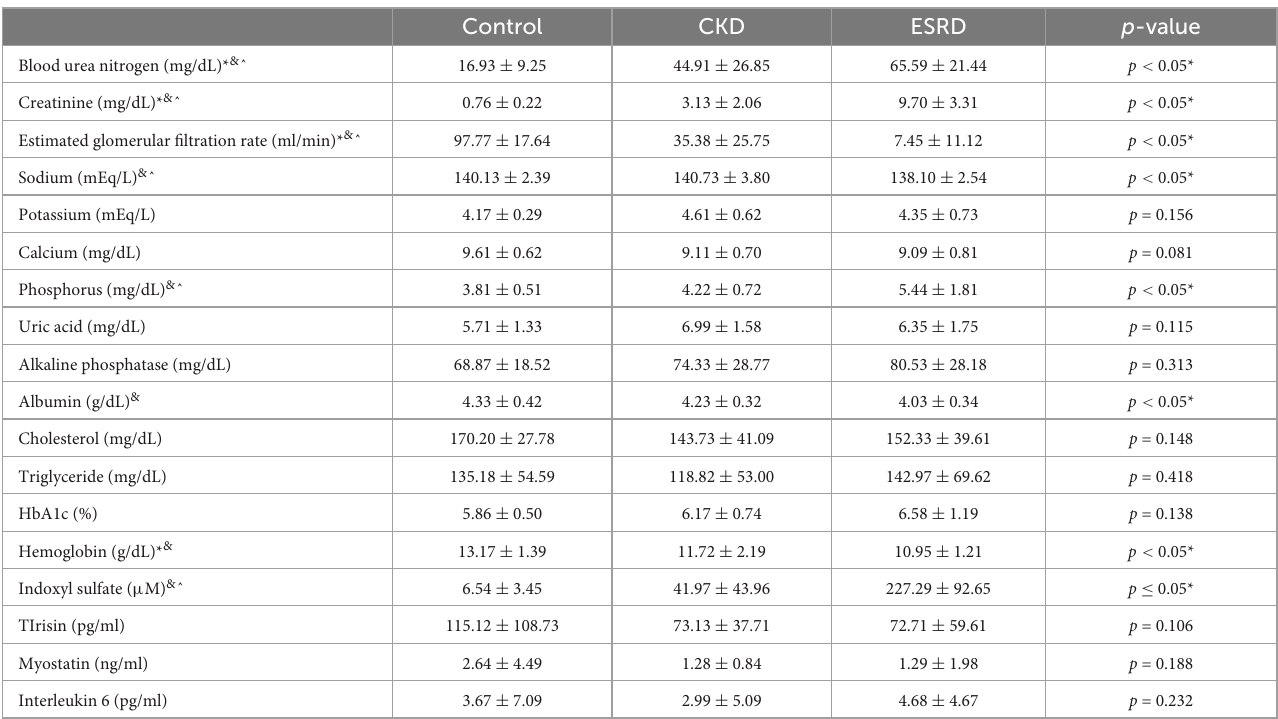
TABLE 3 Hematological and biochemical results by